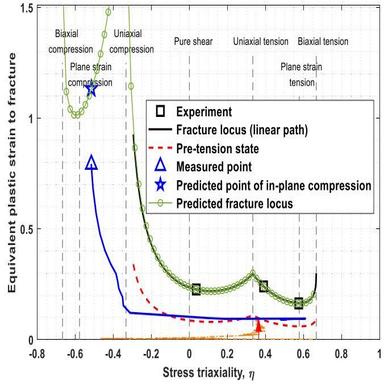
Acquisition of predicted fracture locus based on bilinear strain paths.